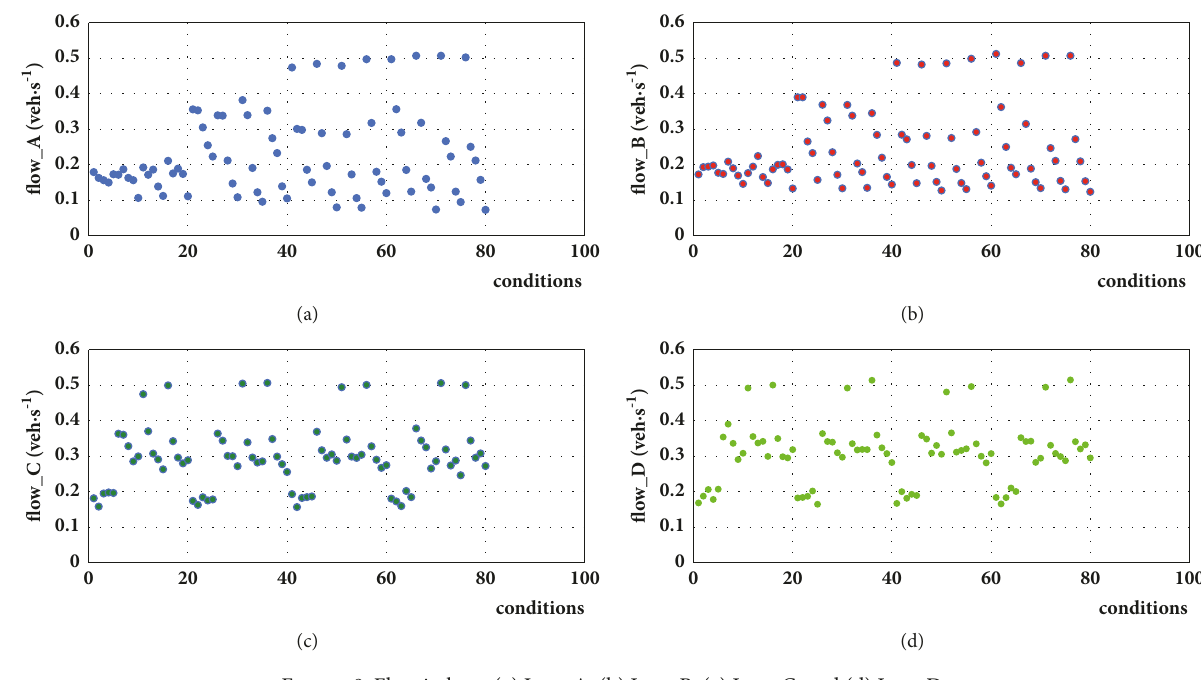
Figure 8: Flow in lane. (a) Lane A, (b) Lane B, (c) Lane C, and (d) Lane D.